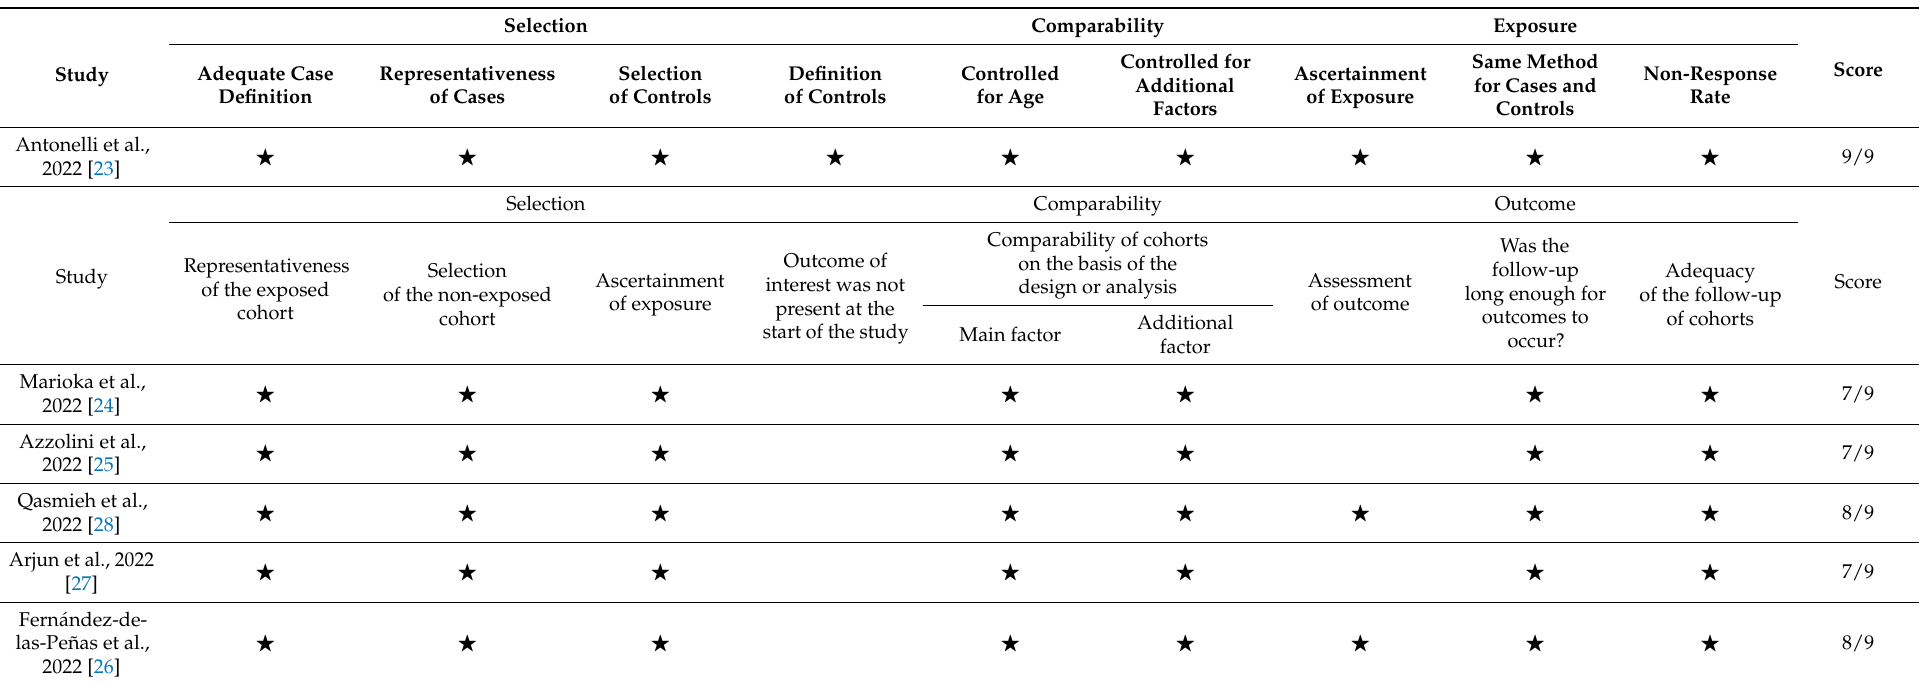
Table 3. Methodological quality (Newcastle–Ottawa Scale—NOS) of studies included in the